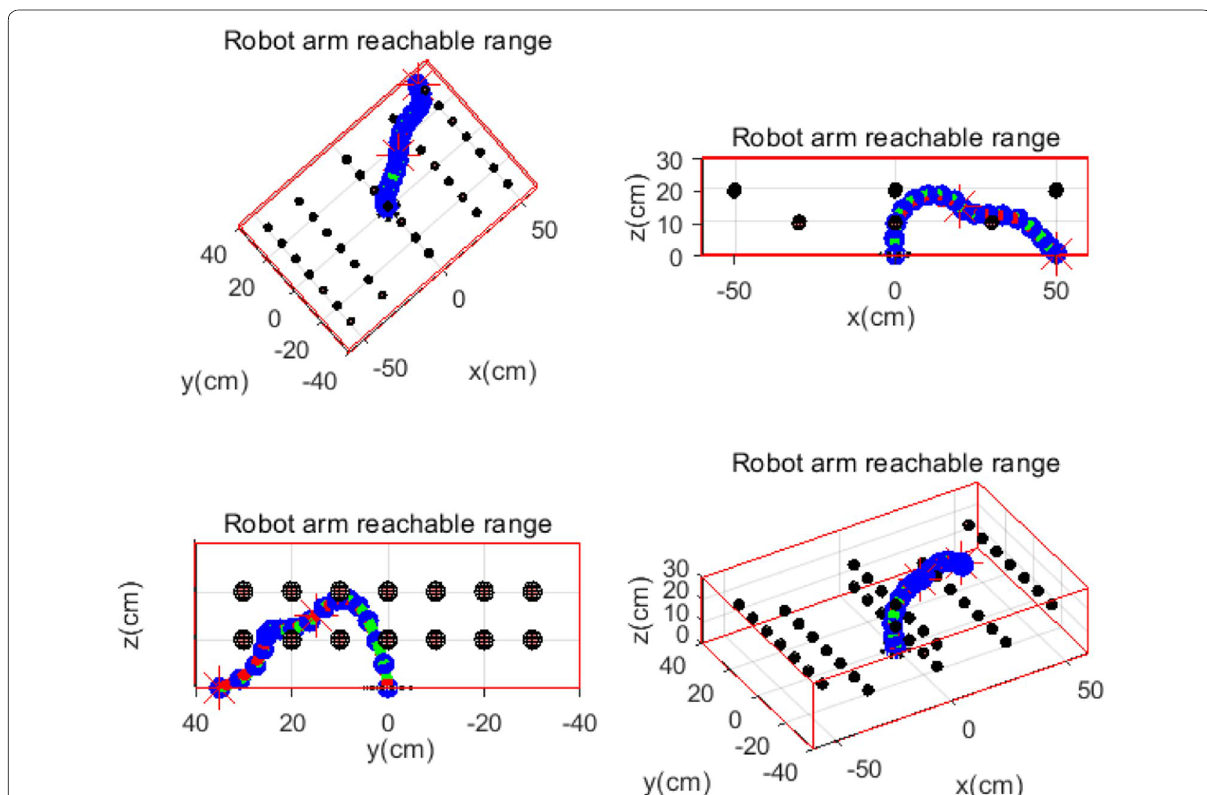
Figure 13 Robot manipulator tracking